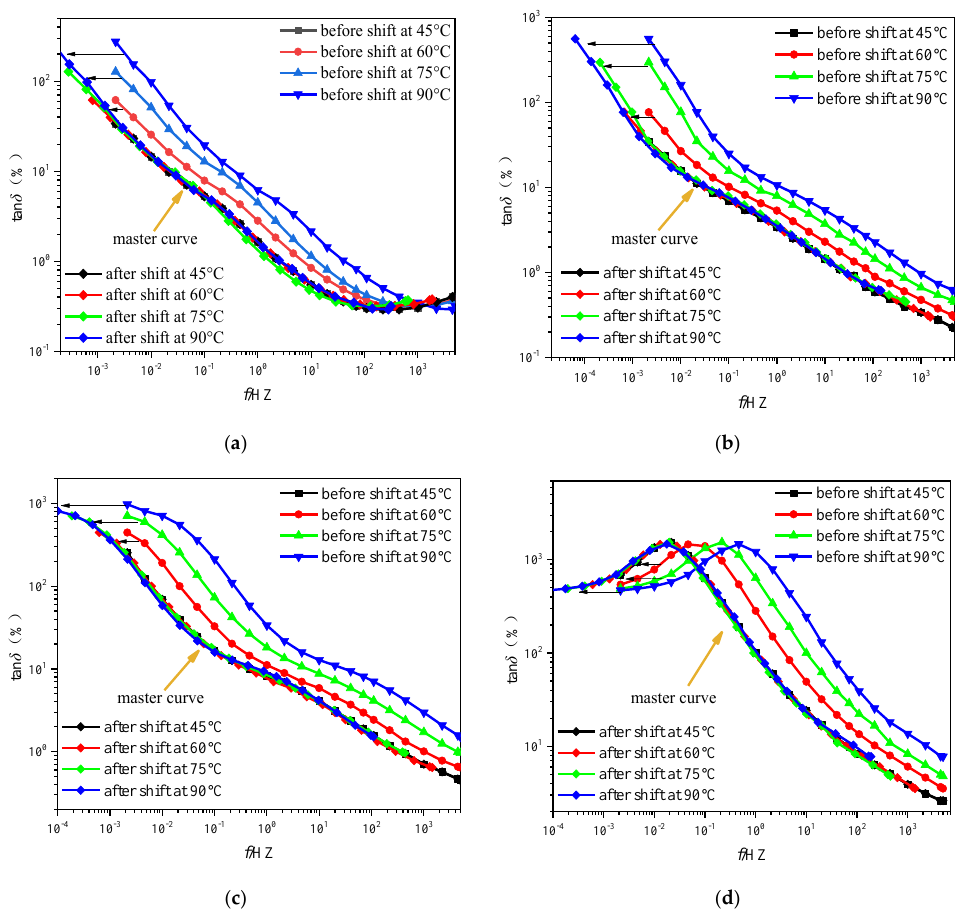
Figure 5. The construction results of the master curve of the unaged pressboard with type